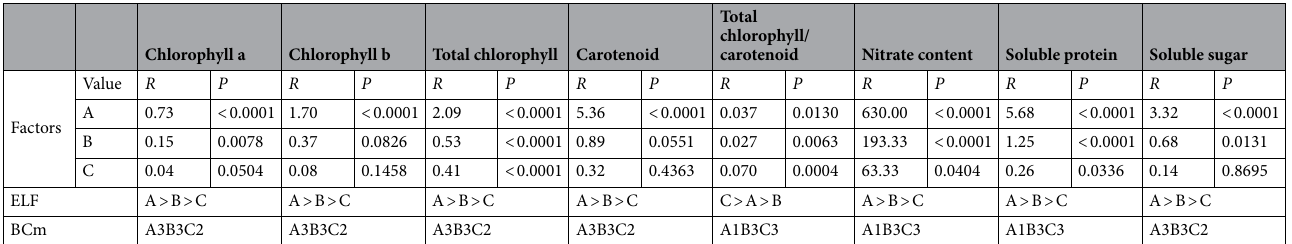
Table 2. Results of the range and ANOVA of the L9 (3 3 ) matrix for the influence of combined, irradiances of LEDs light (Factor A), light spectral ratios (Factor B), and photoperiod (Factor C) on photosynthetic pigments content and biochemical traits of cucumber seedlings. Where: Range value (R), the range of difference between the maximum and minimum average; ELF, The most influential level factors on the parameter gradually; BCm, The best level combination for each parameter; ( P -value), ANOVA analysis of variance.